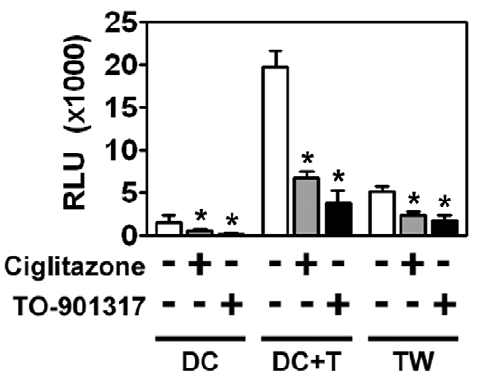
Figure 3. MDDCs are poorly infected with HIV-1 but can mediate trans -infection of T cells. iMDDCs were treated for 48 hours with 100 m M ciglitazone or 1 m M TO-901317, washed extensively, and then incubated with a single round replication- competent HIV-1 reporter virus encoding luciferase and pseudotyped with R5-tropic envelope glycoproteins. After four hours, unbound virus was removed by extensive washing and the MDDCs were incubated directly with PM1 T cells or separated from the PM1 T cells by a Transwell insert with a 0.4 m m membrane for 48 hours. The cells were then harvested, lysed, and assayed for luciferase activity. (n=4) DC, MDDCs cultured in the absence of T cells. DC + T, MDDCs cultured directly with T cells. TW, MDDCs separated from T cells by a Transwell insert. * p , 0.001.